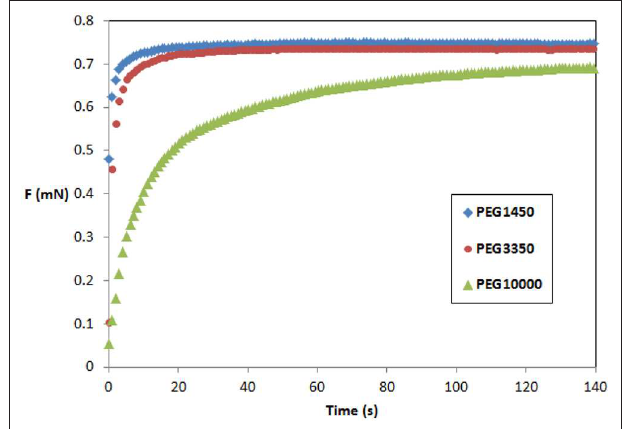
FIGURE 2 | Spontaneous dynamic wetting curves obtained at the tensiometer.